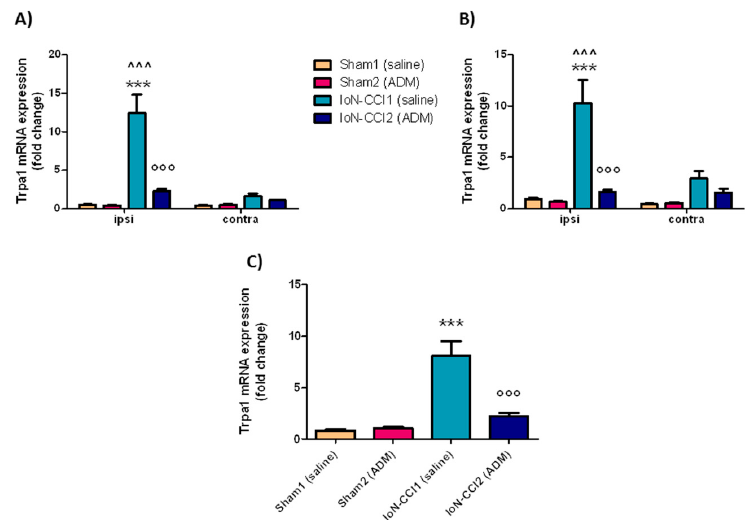
Figure 2. Trpa1 mRNA expression in trigeminal ganglia (TGs) ( A ), cervical spinal cord (CSC) ( B ), and medulla ( C ). Data is expressed as mean + SEM. One way analysis of variance (ANOVA) followed by Tukey’s Multiple Comparison Test or Two-way ANOVA followed by Bonferroni post-hoc test, *** p < 0.001 vs. Sham1 and Sham2 (ipsi), °°° p < 0.001 vs. IoN-CCI1 (ipsi), ^^^ p < 0.001 vs. IoN-CCI1 (contra). test, *** p < 0.001 vs. Sham1 and Sham2 (ipsi), ◦◦◦ p < 0.001 vs. IoN-CCI1 (ipsi), ˆˆˆ p < 0.001 vs. IoN-CCI1 (contra).